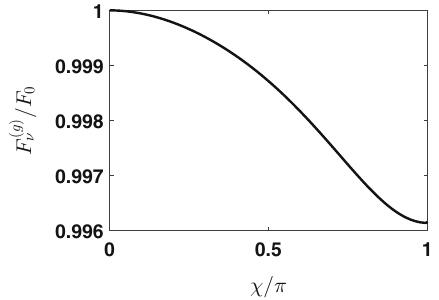
Fig. 3 The ratio of fluxes of massive neutrinos, obtained using Eq. (8), and scalar particles in their scattering off a Schwarzschild BH versus the scattering angle χ normalized by π